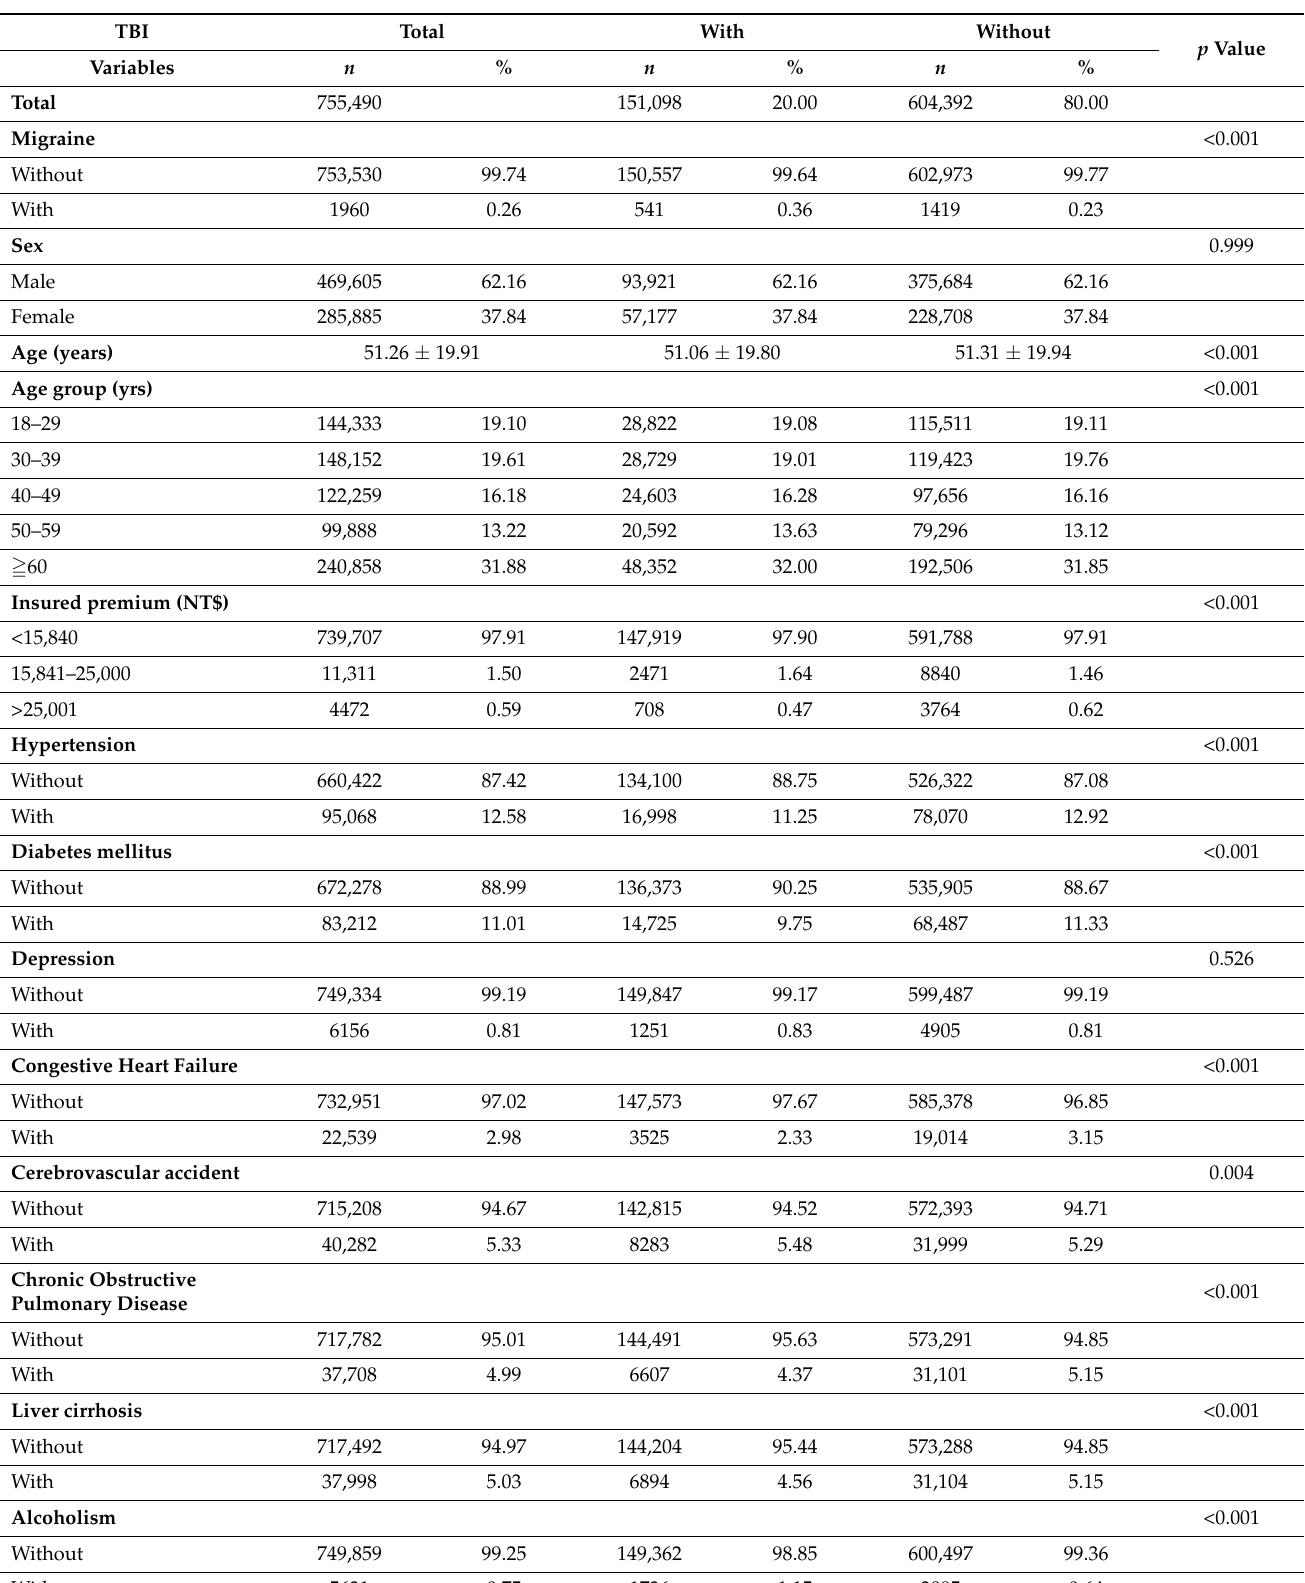
Table A2. Characteristics of the TBI and non-TBI cohorts at the end of